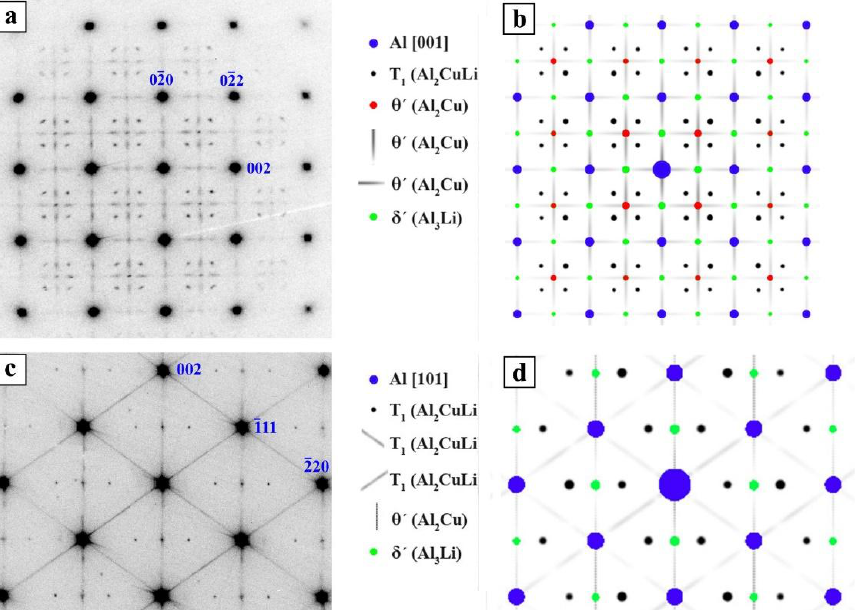
Figure 5. Energy-filtered experimental ( a , c ) and simulated ( b , d ) electron diffraction pattern of the PA state. Zone axis is [100] Al in ( a , b ), and [110] Al in ( c , d ) (adopted from [33] ).